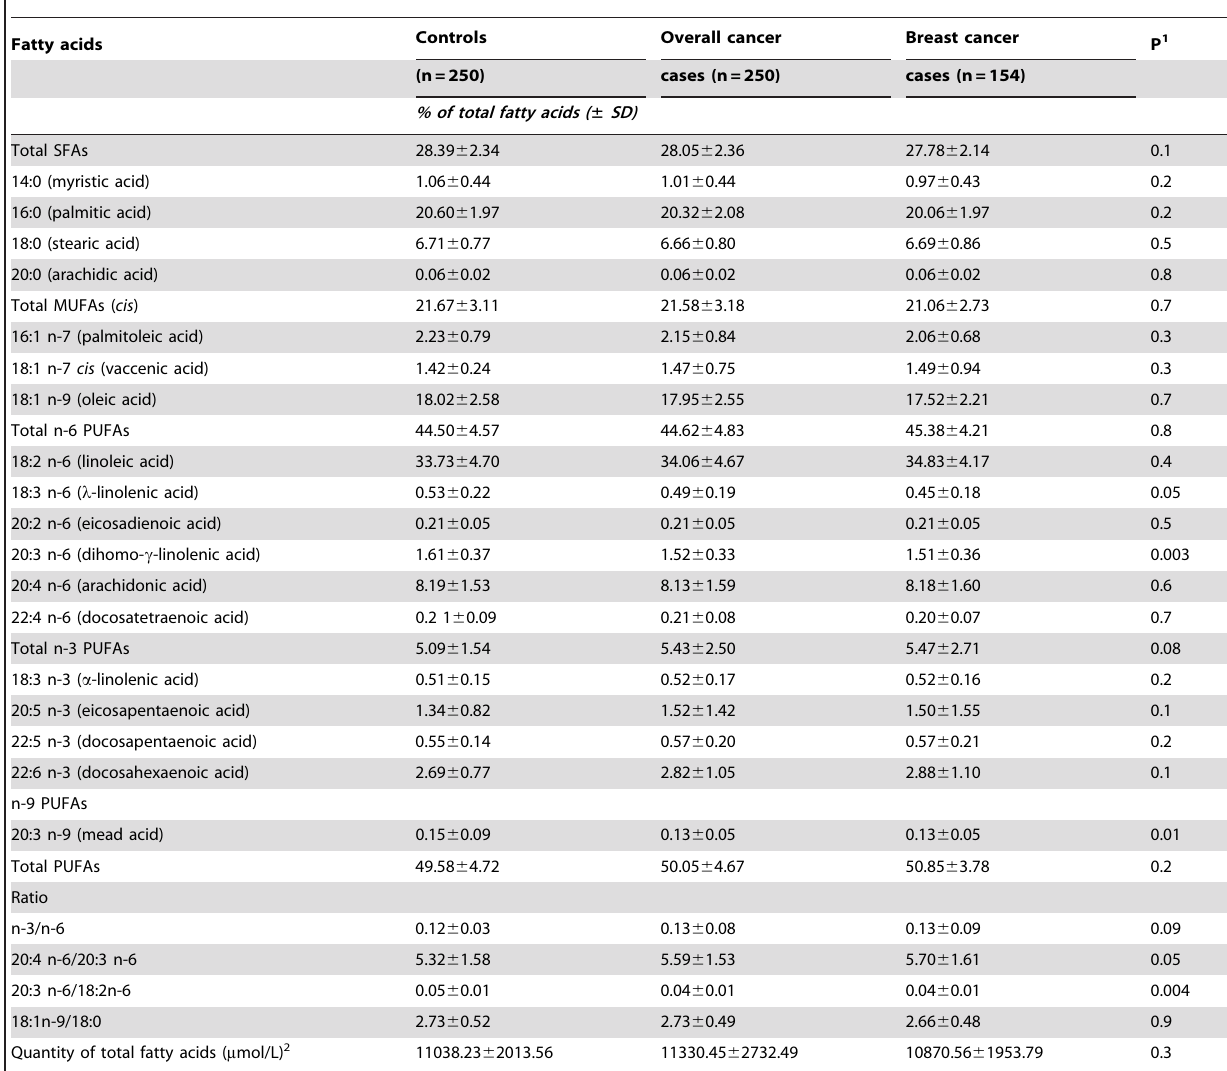
Table 2. Plasma concentrations of fatty acids at baseline among cases and controls.